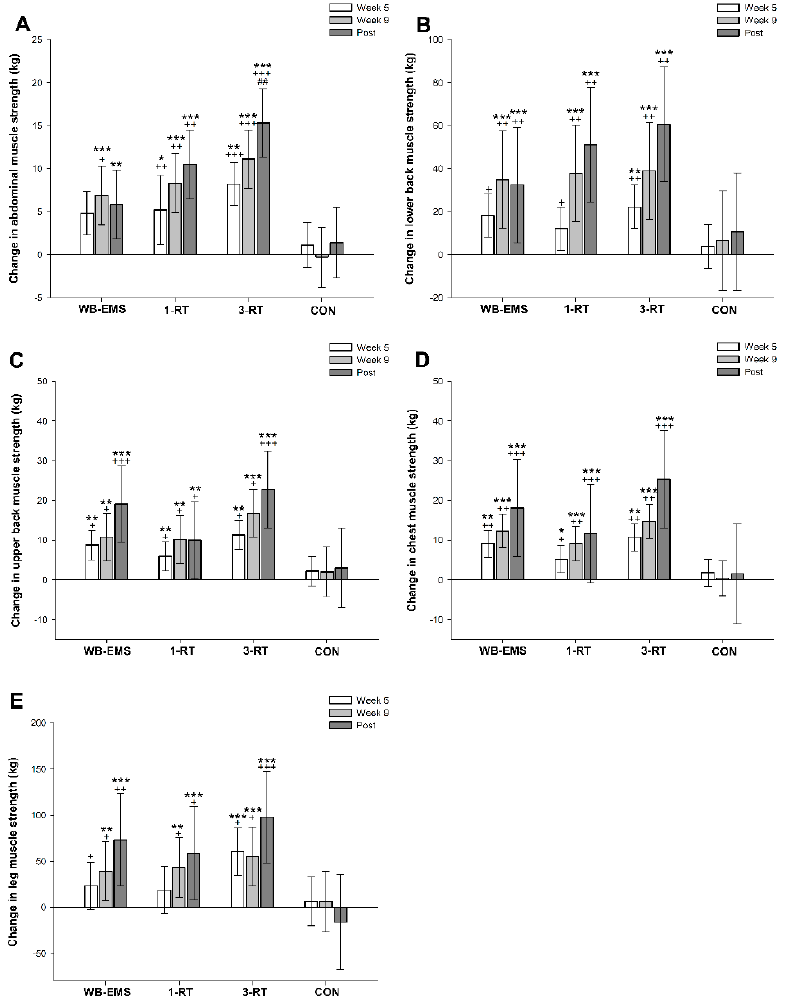
Figure 4. Changes in abdominal ( A ), lower back ( B ), upper back ( C ), chest ( D ), and leg muscle strength ( E ). * ( p < 0.05), ** ( p < 0.01), *** ( p < 0.001): significantly different from pre-intervention; + ( p < 0.05), ++ ( p < 0.01), +++ ( p < 0.001): significant difference vs. CON. ## ( p < 0.01) significant difference vs. WB-EMS.